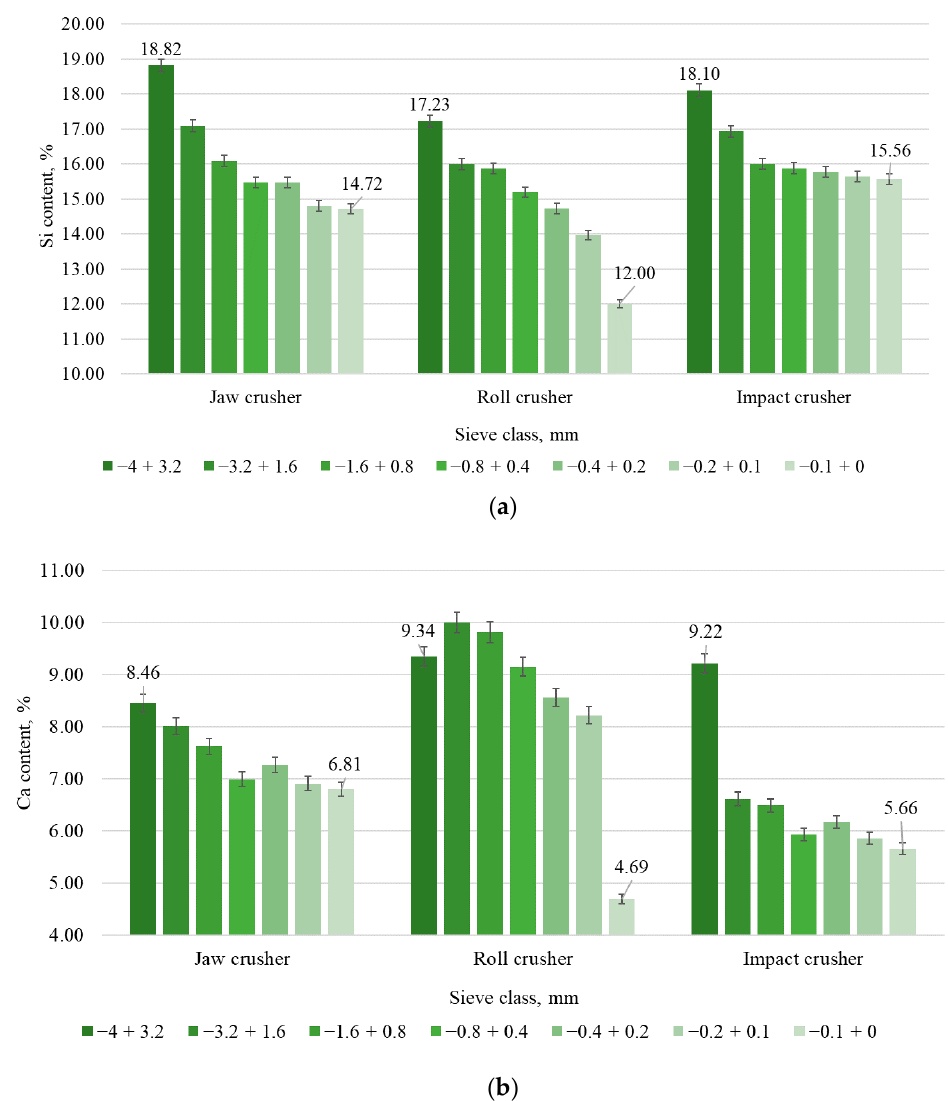
Figure 9. Silica ( a ) and calcium ( b ) content in the sieve classes during the crushing of the CNO samples in jaw, roll and impact crushers. Table 7. Distribution of silica and gold in the sieve classes for BDO crushing products. Sieve